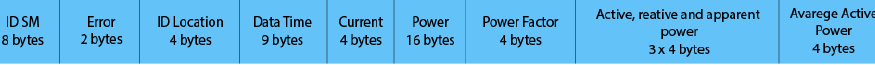
Figure 4. SMs Package with 63 bytes